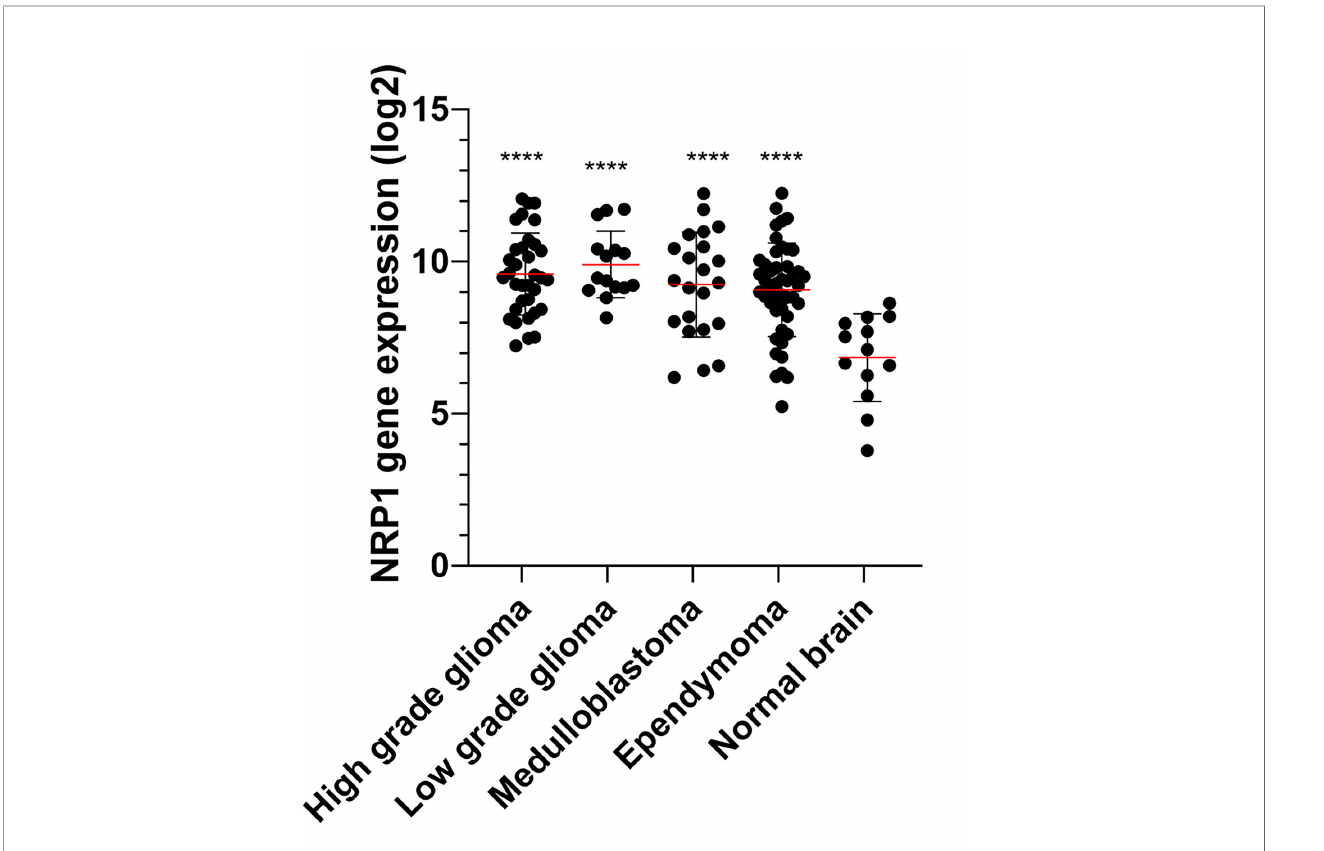
FIGURE 2 | NRP1 expression (Log2) in normal brain and pediatric brain tumor samples. Microarray (Affymetrix HG-U133 plus 2) expression of 13 normal, 34 high grade glioma, 15 low grade glioma, 22 medulloblatoma and 46 ependymoma were extracted from the GSE50161 dataset (http://www.ncbi.nlm.nih.gov/geo/query/acc.cgi?acc= GSE50161). The signi fi cance was evaluated by a one-way ANOVA followed by a post-hoc Tukey for multiple comparisons. ****P < 0.001 versus normal